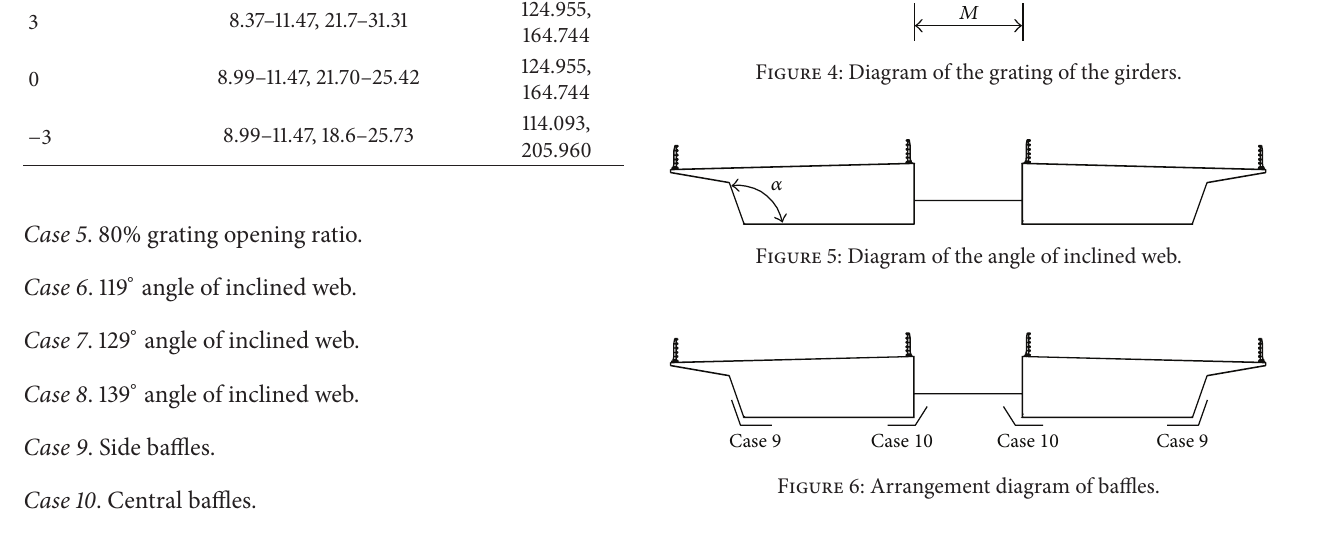
Table 3: Characteristics of the VIV of the bridge. Wind attack angle (deg.)